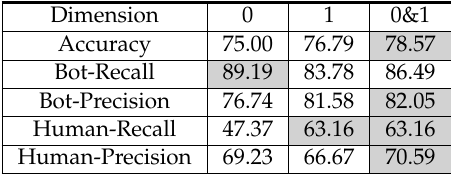
Table 1. Detection results for different metrics and dimensions. The cells for the best result in each column are colored